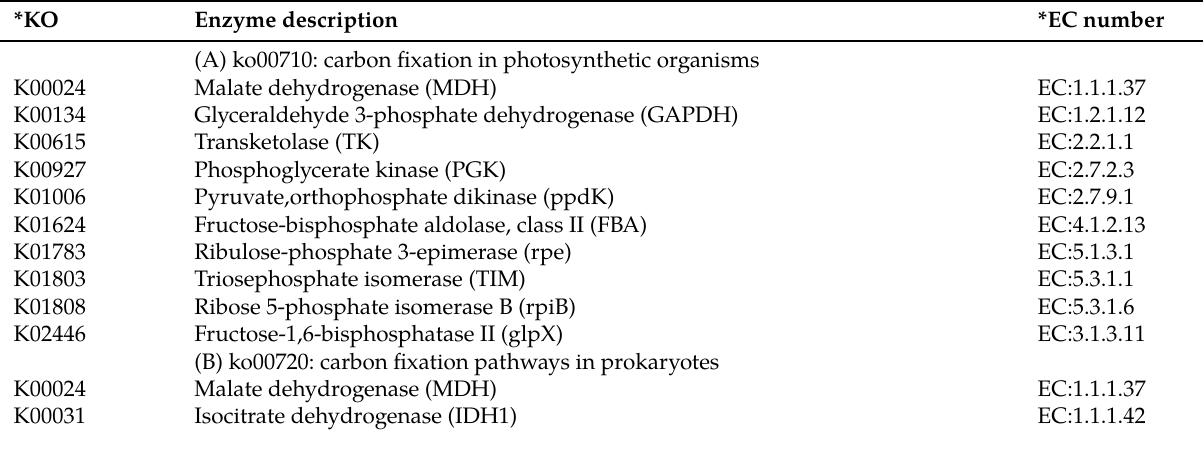
Table 1: Carbon fixation enzymes of the reductive citric acid cycle (rTCA) in Mycobacterium tuberculosis. *KO Enzyme description *EC